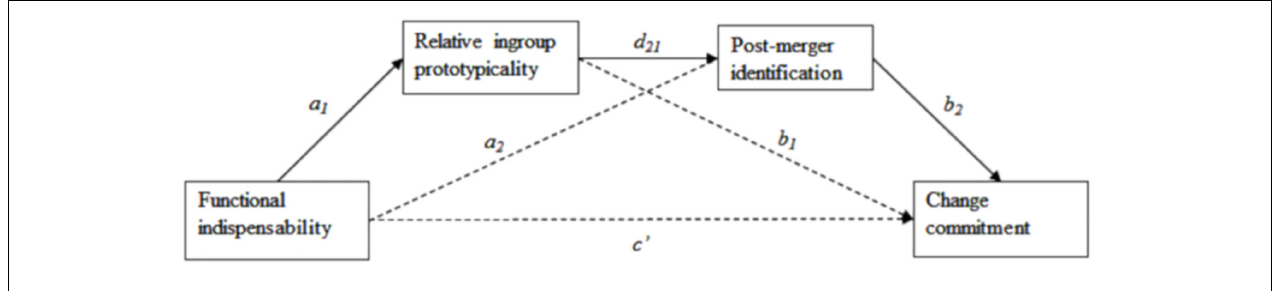
FIGURE 1 | Conceptual model of